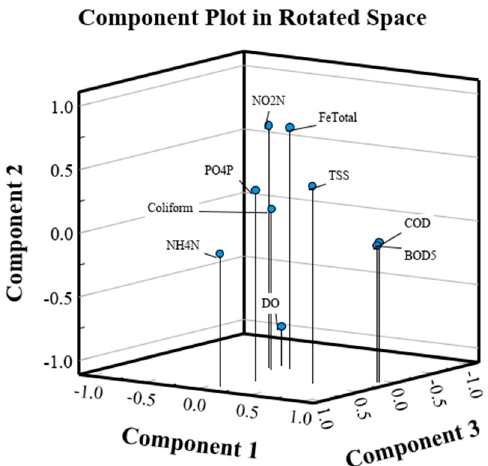
Figure 3. Plotted eigenvalues of components 1–3.